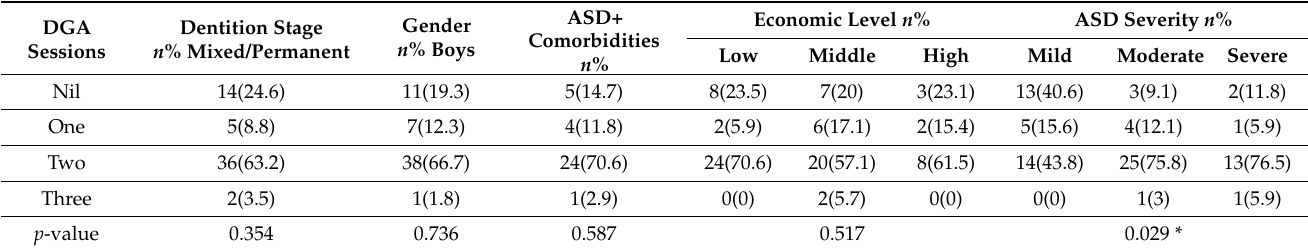
Table 7. Association of ASD children’s demographic profile and medical status with the number of dental general anesthesia sessions delivered ( n = 82).